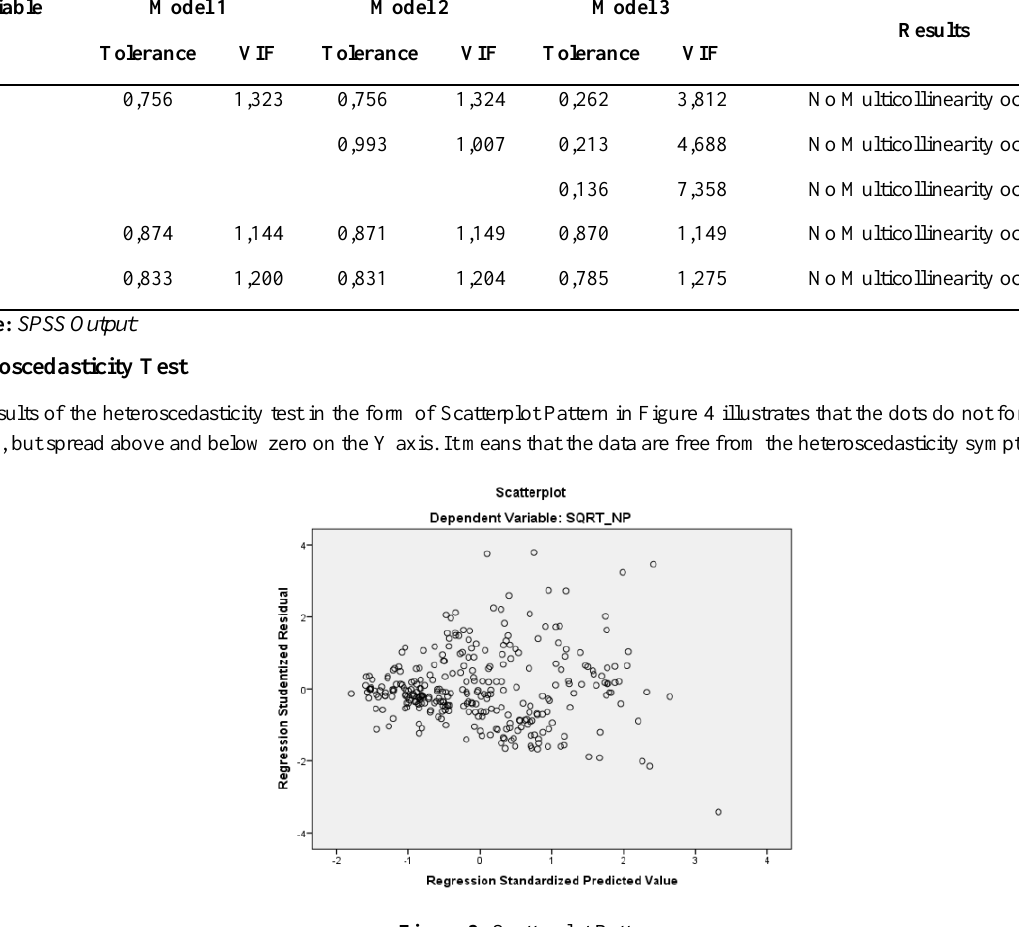
Figure 3: Scatterplot Pattern.